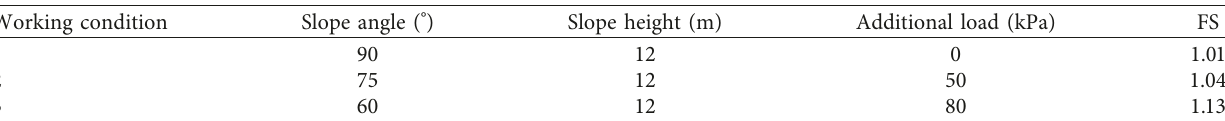
Figure 11: Numerical simulation result of slope with anisotropy. (a) Point safety factor, (b) degree of reinforcement demanding, and (c) the azimuth ( θ ) of Δ σ . 3 Table 4: Design condition.